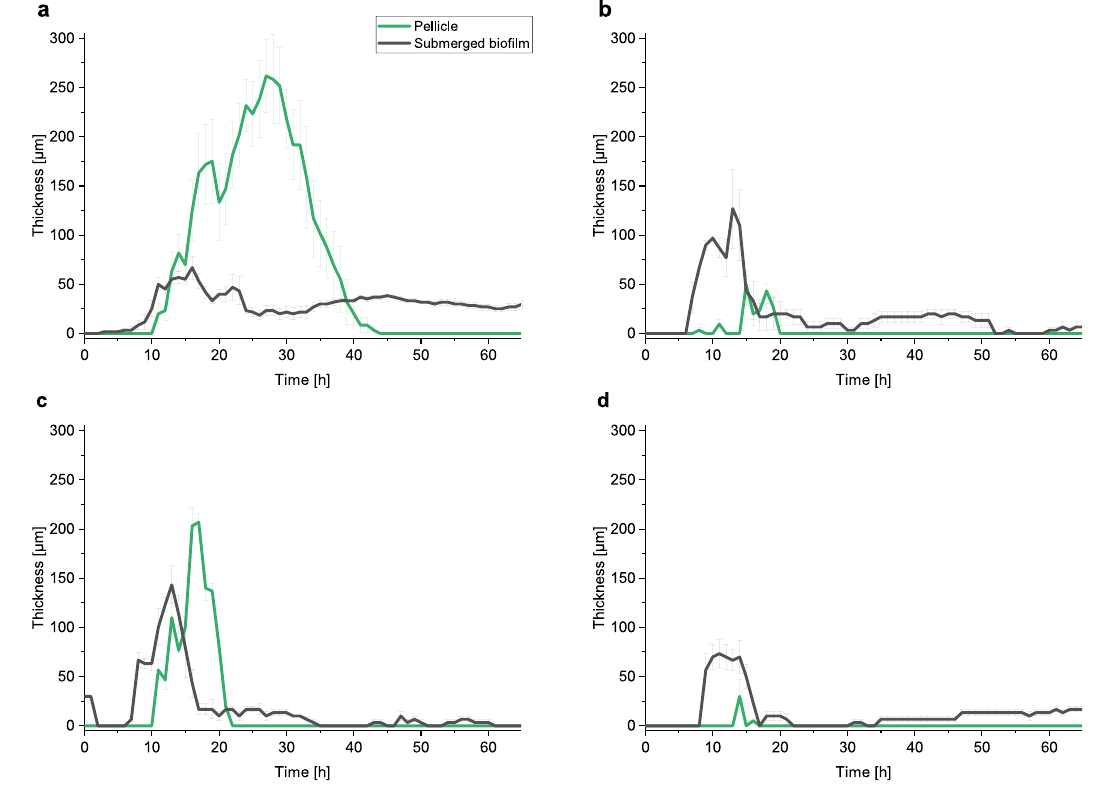
Fig. 5 Pellicles and submerged bio fi lms thicknesses . Temporal variations of pellicle and submerged bio fi lm thicknesses for B. subtilis PS-216 wild type ( a ), Δ tasA ( b ), Δ epsA-O ( c ), and Δ epsA-O Δ tasA ( d ) mutant. Results are presented as mean ± standard error from 3 to 6 independent biological